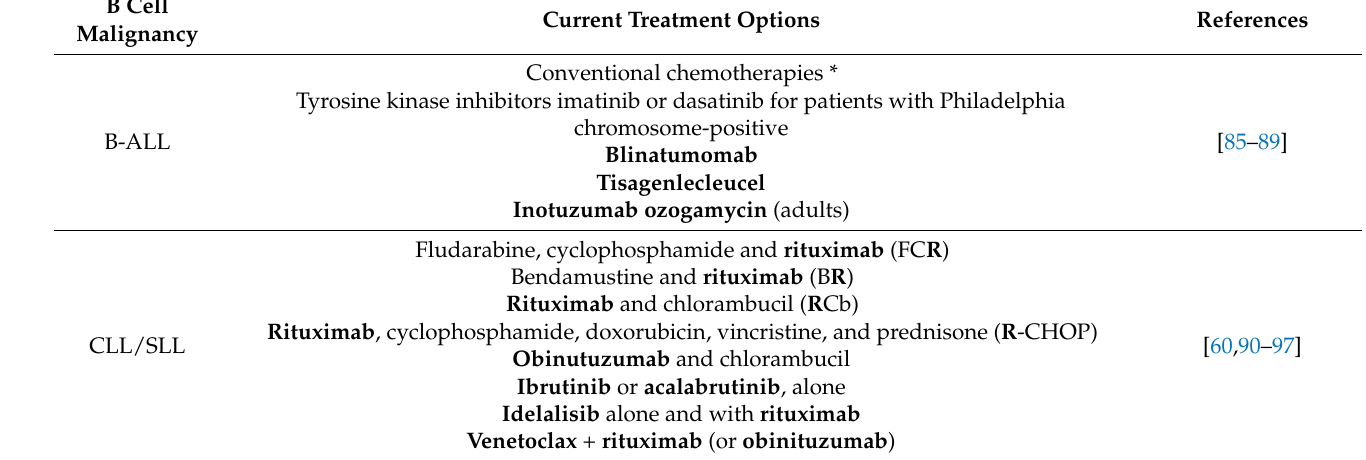
Table 2. Current treatments of B cell malignancies with FDA-approved drugs targeting Bcl-2, BTK, PI3K and TAAs (CD19/CD20/CD22/CD38), alone or in combination and as first- or second-line